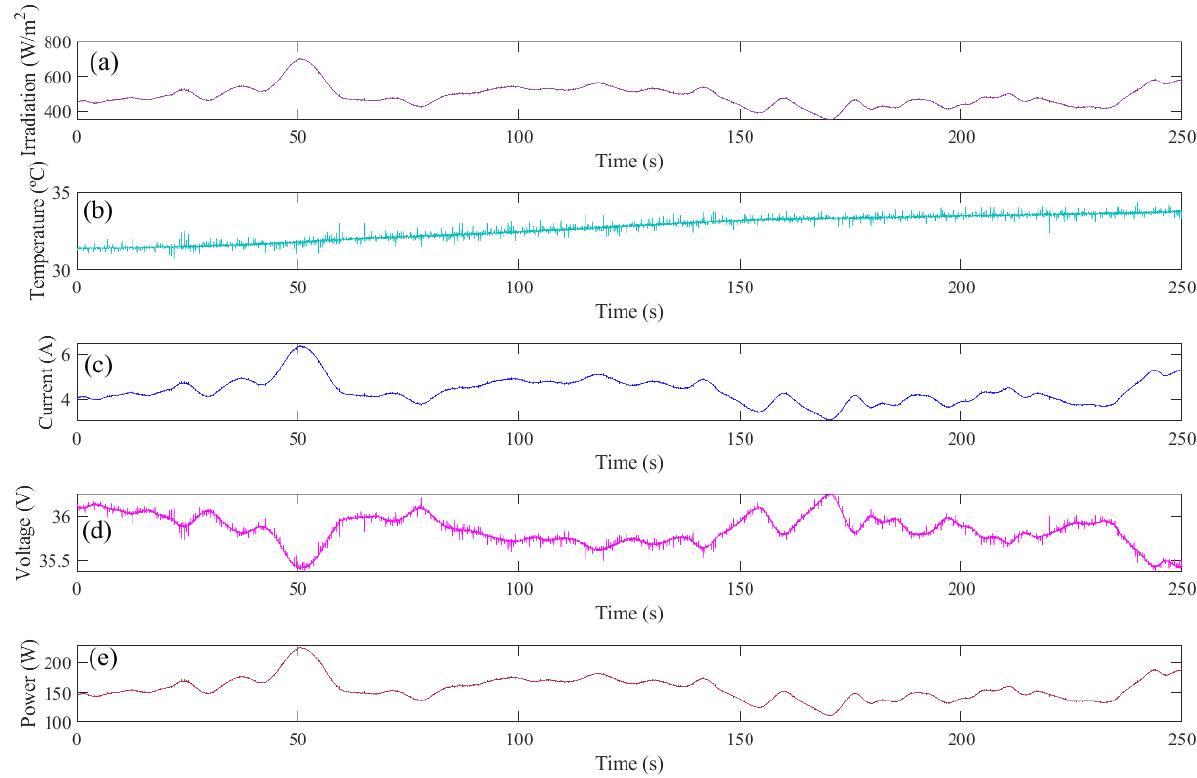
Figure 22. MPPT based on RNN and MPC: ( a ) Irradiation (W/m 2 ); ( b ) Temperature ( ◦ C); ( c ) PV current; ( d ) PV voltage; ( e ) PV